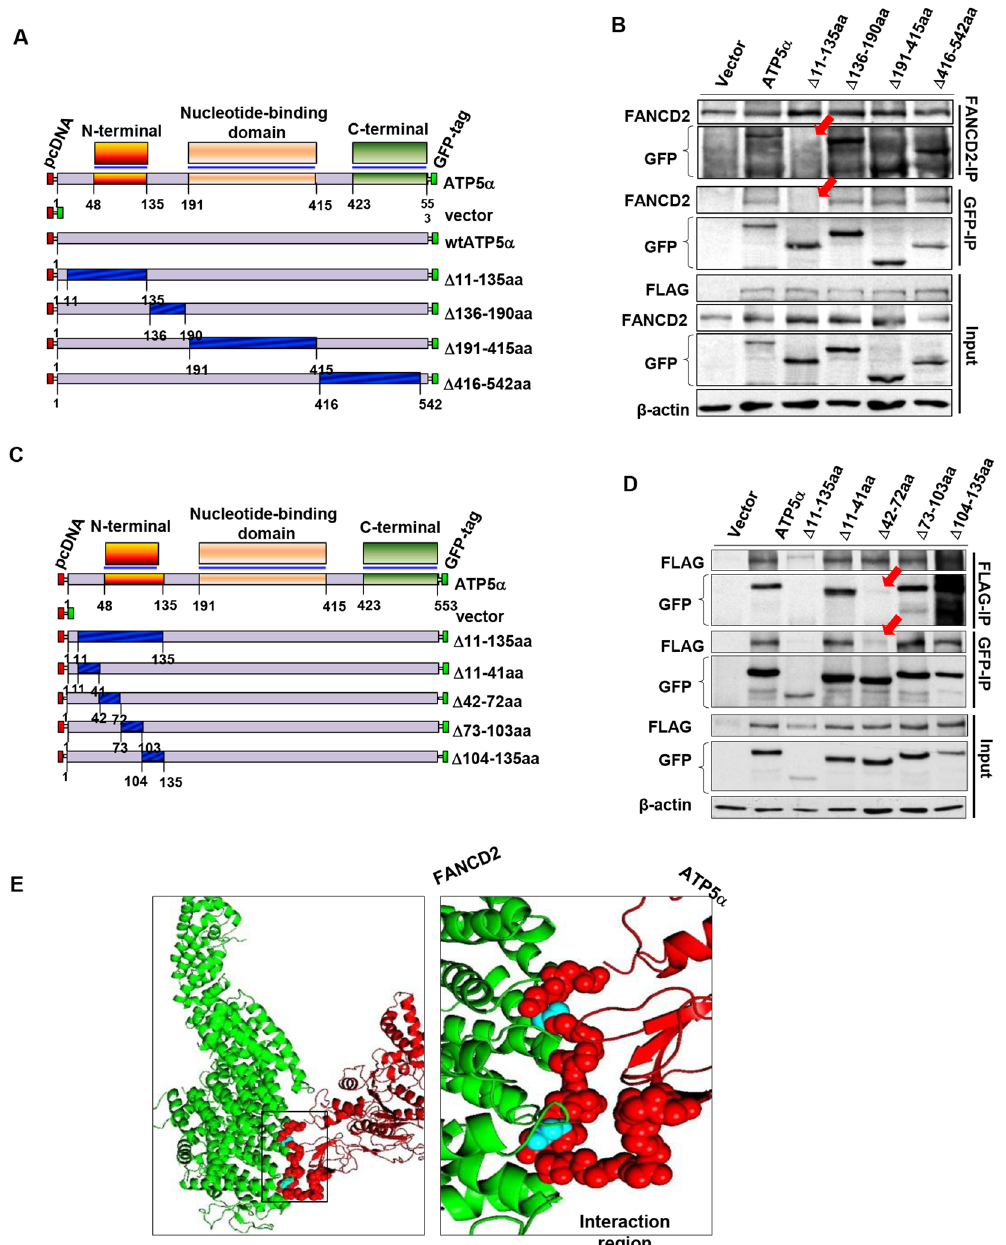
Figure 3. N-terminal of ATP5 α is responsible for its interaction with FANCD2. ( A ) Schematic representation of a series of deletions in ATP5 α protein. Each deleted part was marked with dark blue, whereas the remaining portion was shown in light gray. ( B ) Δ 11-135aa of ATP5 α contributes to the interaction between ATP5 α and FANCD2 proteins. The six sets of reverse-IP-WB were performed using 293T cells transfected with a series of deletion constructs respectively (See Supplementary Fig. 3 for equal transfection efficiency). FANCD2 and mtGFP-ATP5 α ( Δ 11-135aa) are not detectable in each other’s IP pellets (indicated with red arrowhead). ( C ) Schematic representation of a series of sub-deletions in the region AA11-135 of ATP5 α . Each deleted part was marked with dark blue, whereas the remaining portion was shown in light gray. ( D ) AA42-72 of ATP5 α is responsible for its association with FANCD2. The seven sets of reverse-IP-WB were performed using 293T cells transfected with a series of deletion constructs (See Supplementary Fig. 3 for the equal transfection efficiency), respectively. Flag or GFP was not detectable in each other’s IP pellets prepared from cells carrying GFP-mtATP5 α ( Δ 11-135aa) or ( Δ 42-72aa) (indicated with red arrowheads). ( E ) The molecular docking of ATP5 α and FANCD2. The predicted structure of human ATP5 α (red), based on the crystalized ATP synthase subunit alpha of bovine (PDB: 2wss.A) using I-TASSER, adapted well to that of FANCD2 protein (green) (PDB: 3S4W.2). This specific region (42-72aa) of ATP5 α interacted with FANCD2 was described as red